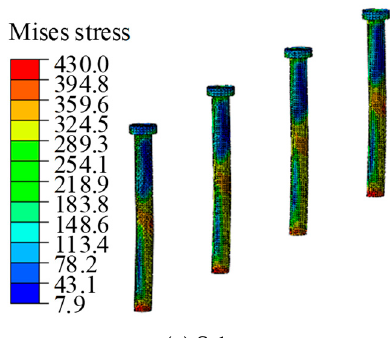
Figure 13. Mises stress of the studs in the push-out specimens at the ultimate bearing capacity (MPa).